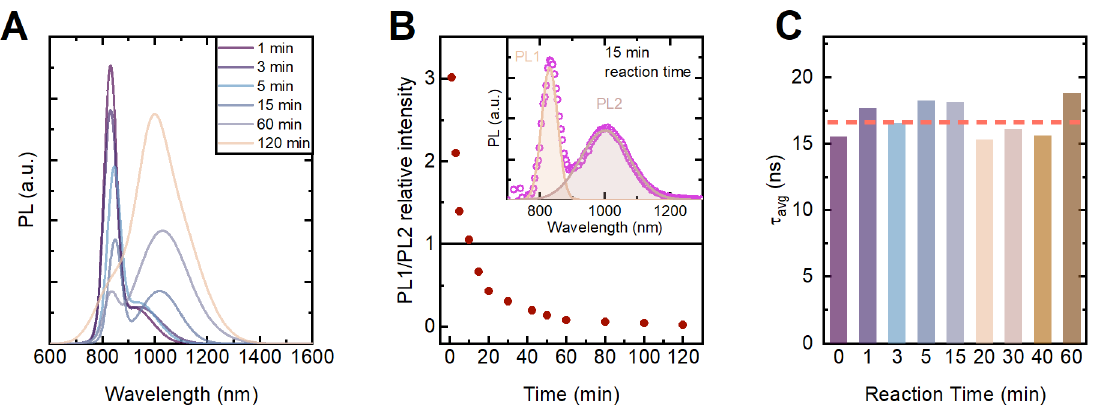
Figure 3. ( A ) Photoluminescence spectra; ( B ) relative PL intensity of 830 nm band (PL1) and >950 nm PL band (PL2), on inset–typical PL deconvolution on a 15 min-aliquot; ( C ) intensity-averaged PL decay times (at 830 nm) of 4% doped HgTe at different reaction time.